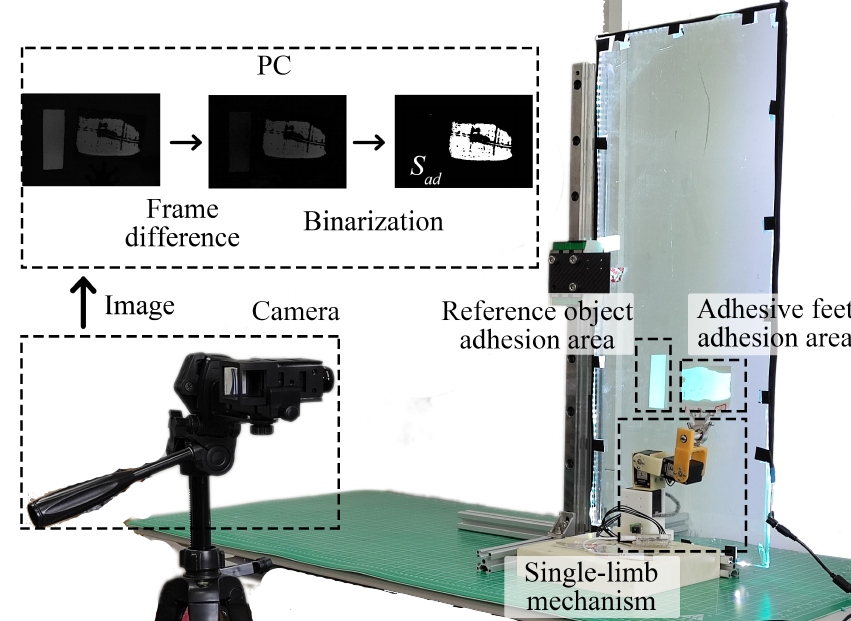
Figure A1. Adhesion area test platform and adhesion area detection process offline. The adhesion area actual image captured by the camera is uploaded to PC for image processing [28]. The frames containing only markers (non-adhesion) were recorded as f bg , and the frames after adhesion were recorded as f src . Through the difference between the two frames (Frame difference), the frame f ad containing only adhesion region was obtained, which was binarized and the total number of pixels of adhesion region in the frame was calculated (Binarization). The actual adhesion area is obtained by the ratio of the number of pixels of the reference object to the actual